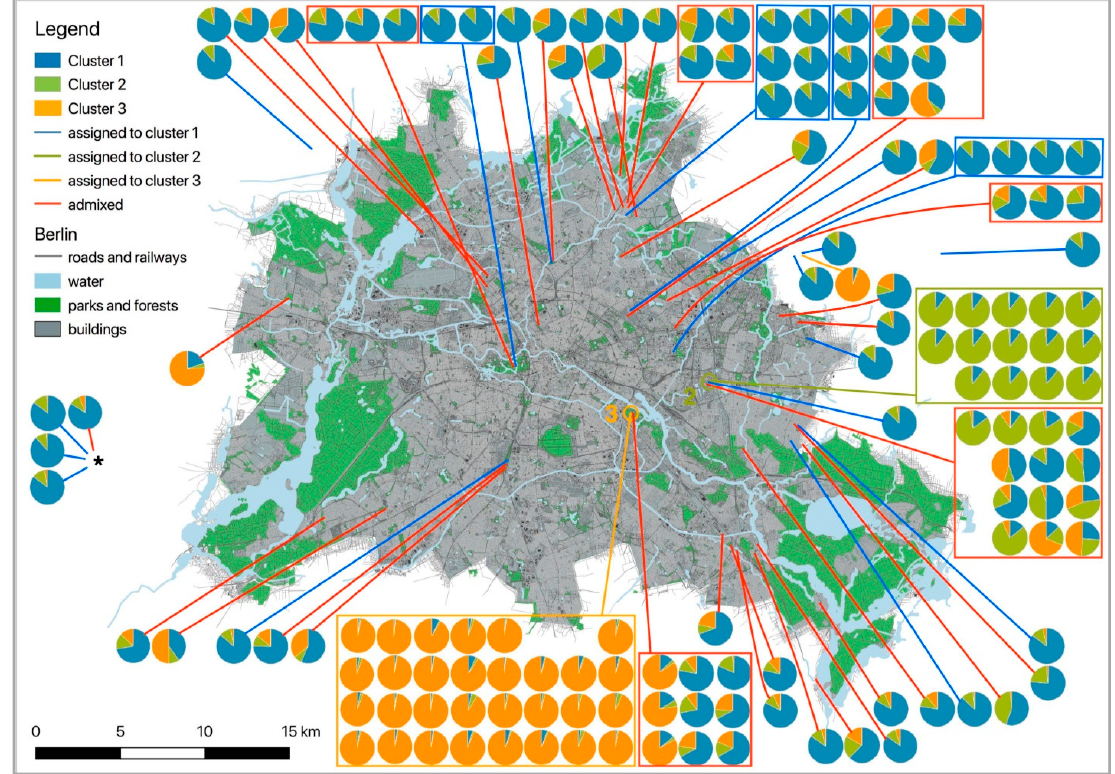
Figure 2. Map of Berlin and its surroundings indicating the locations of all samples displayed as pie charts showing the proportional membership of each individual in either one of three clusters (determined by S tructure , including related animals). Di ff erent colours indicate membership to di ff erent clusters. Q -values were taken from Table 2. Individuals that belong to a cluster ( Q ≥ 0.85) are grouped within squares framed in the colour of their cluster. Admixed individuals are framed in red squares. Solid lines connect groups and individuals with their sampling location. For individuals assigned to either one of the three clusters, colours of lines correspond to cluster membership (cluster 1: blue, cluster 2: bright green, cluster 3: bright orange). Red lines connect admixed individuals to their sampling site. Pie charts of the four samples that were collected outside of the displayed city area are given on the left side, indicated by *. Locations “Tierpark” and “Treptower Park” are indicated by coloured circles and cluster number (2, green: Tierpark; 3, orange: Treptower Park). Expected heterozygosity ( H E ) for individuals of the most wide-spread cluster (cluster 1: H E = 0.685; N = 29) was even slightly higher than the value of H E = 0.68 measured in a country-wide study in the Czech Republic (average sampling site distances > 450 km; [34]), indicating that in Berlin the urban environment does not lead to a reduction of genetic variability in hedgehogs. Because individuals from clusters 2 and 3 of our study were confined to single parks, either to the “Tierpark” or to the “Treptower Park”, we expected to detect low observed ( H O ) and expected heterozygosities there. Even though the values were indeed lower than in the widespread cluster 1, they were only lower by a small margin (cluster 2: H O = 0.557 / H E = 0.524; cluster 3: H O = 0.578 / H E = 0.651) and even slightly higher than those measured in free ranging hedgehog populations from New Zealand a ff ected by a founder e ff ect ( H O = 0.42–0.52 / H E = 0.51–0.57; [62]). These values were also in the range of values for the three urban clusters detected in Zurich ( H O / H E = 0.6 / 0.605; 0.523 / 0.568; 0.631 / 0.627), although pairwise